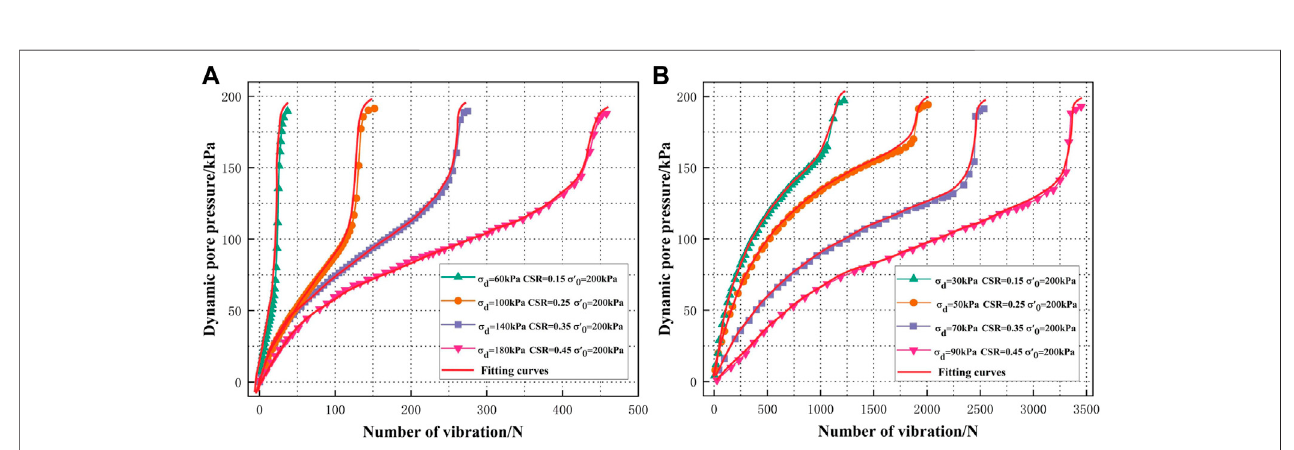
FIGURE 8 | Development curves of accumulated pore pressure of PG under different vibration conditions: (A) unidirectional vibrations condition; (B) bidirectional vibrations condition.